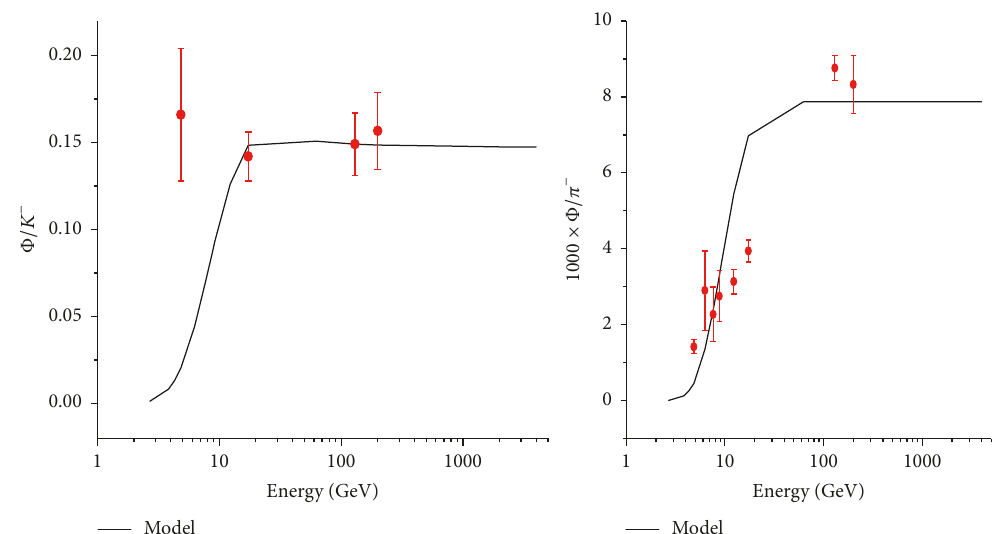
Figure 6: Energy dependence of various unlike particle ratios.